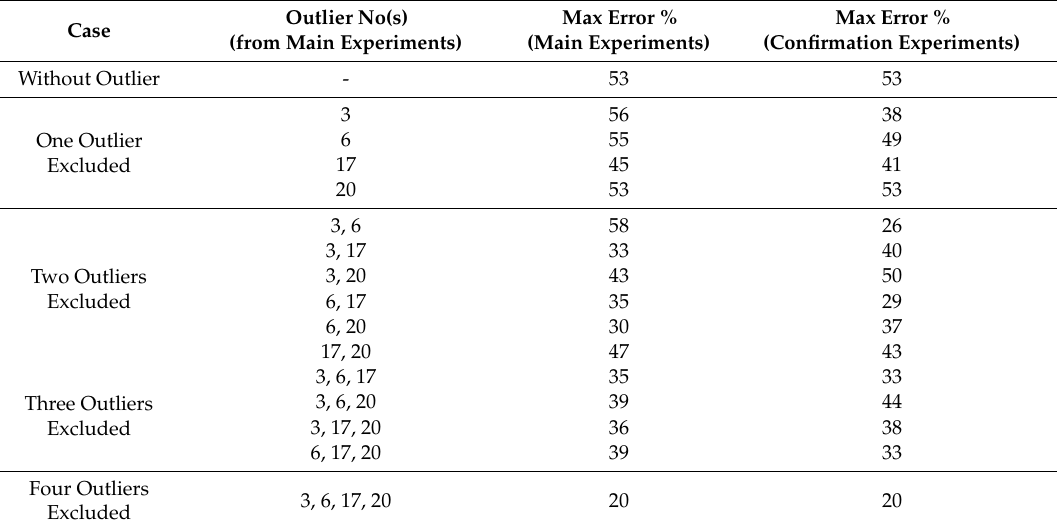
Table 6. Leakage rate error between experiments and closed form